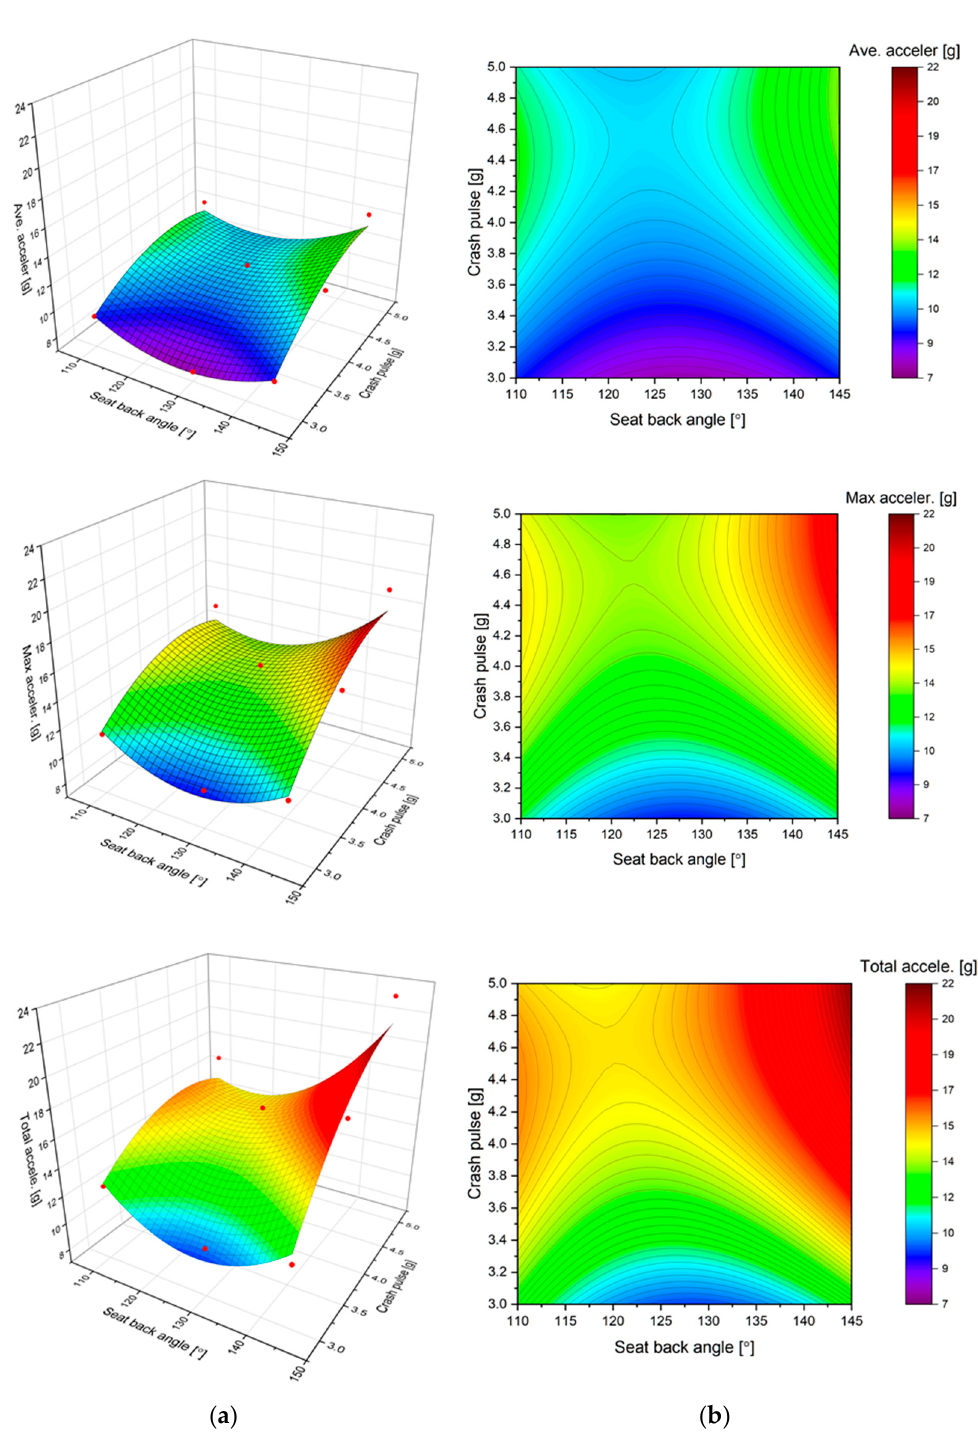
( b ) Figure 7. Predicted (estimated) response for the duration of acceleration: ( a ) fitted response surface; ( b ) fitted response profile. A comparison of average, maximal, and total acceleration (explained in Figure 5) is shown in Figure 8. The duration of the acceleration pulse affects its average value. The average acceleration calculated with the HIC represents the lowest value. This is because it is calculated over the range of peak duration. In consequence, the peak of acceleration, with no respect to the duration, represents a higher value. The mean difference between the measured peak and calculated average acceleration is 26%, whereas the highest dif- ferences exist at an angle of 145° and a crash pulse of 5 g. Similarly, the highest value